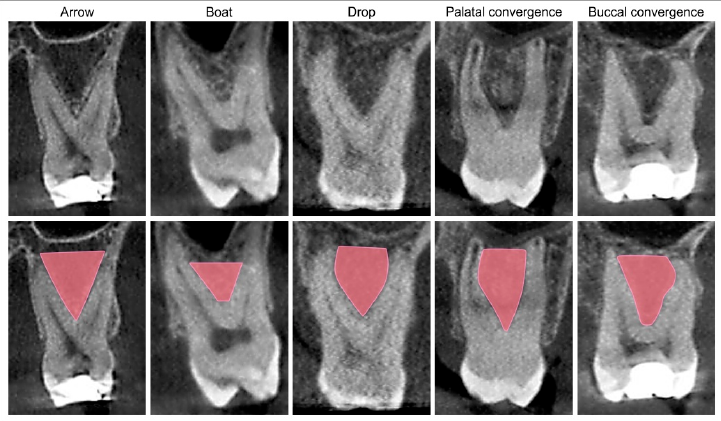
Figure 2. Typical maxillary molars’ IRS shapes (with the marked borders) in the coronal CBCT